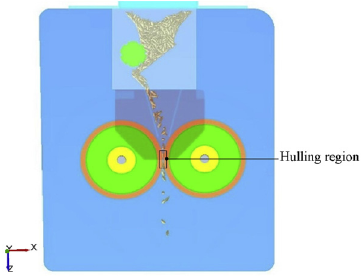
Figure 13. Simulation of grain screening process. ( a ) Simulation of grain–straw separation [107]; ( b ) simulation of sieving process of maize grain [187].